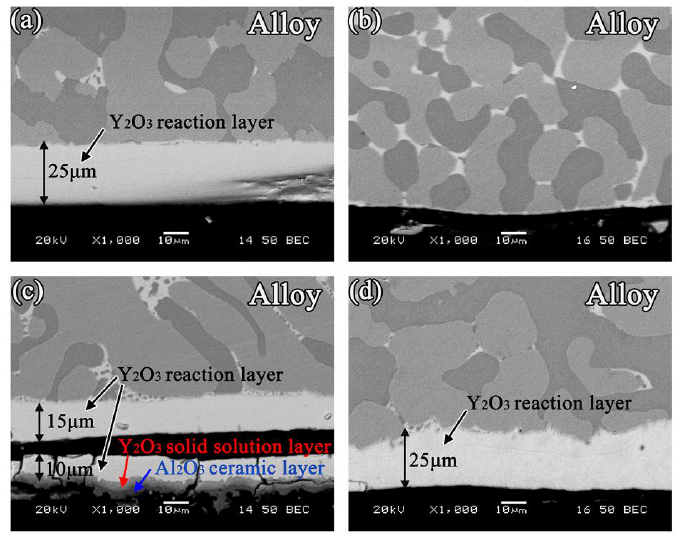
Figure 6. Morphologies of the metal/substrate interfaces: ( a ) MgO; ( b ) Y 2 O 3 ; ( c ) Al 2 O 3 ; and ( d ) ZrO 2 .